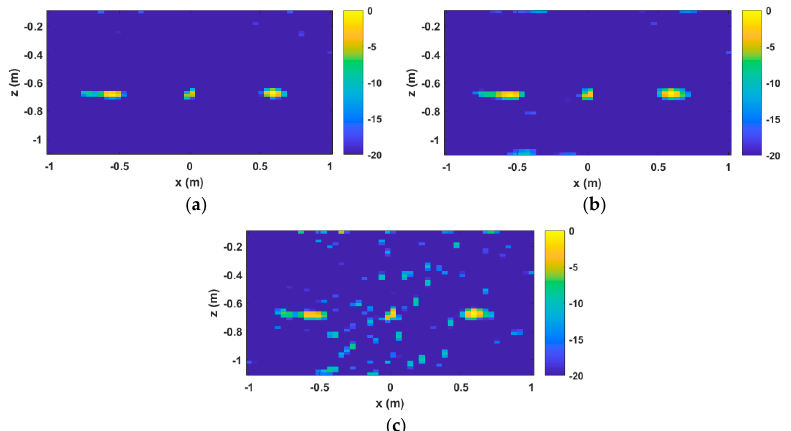
variation minimization); ( c ) standard 𝑙 (cid:2869) ‐ norm minimization.